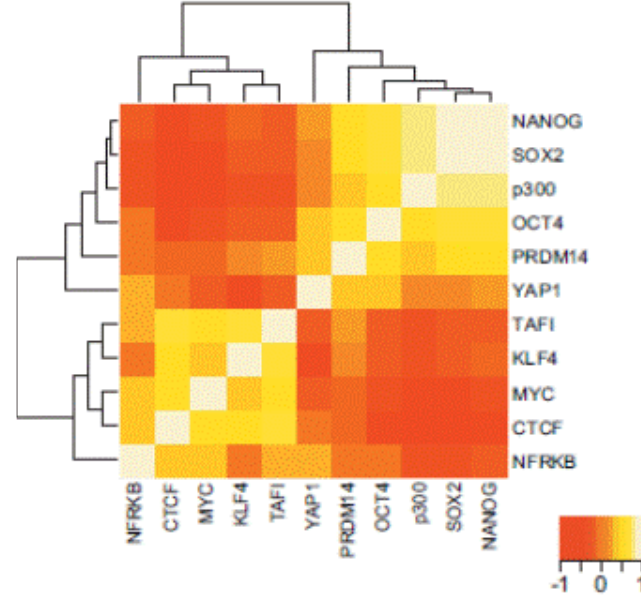
Figure 8: Co-occupation map of TF in